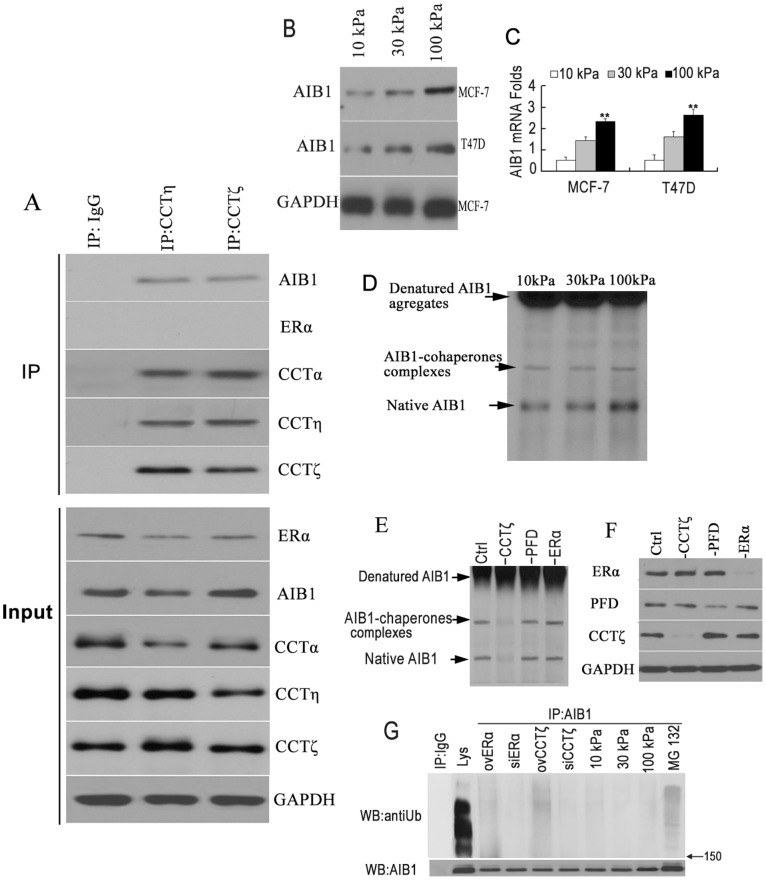
CCT6 (ζ) interacts with AIB1, and stimulates AIB1 refolding via a PFD-independent pathway.(A) MCF-7 cells were cultured on 100-kPa substrates, and then analyzed by co-immunoprecipitation (co-IP) assay followed by immunoblotting (IB) analysis after 72 h. (B) The expression of AIB1 was then assessed in two breast cancer cell lines (MCF-7 and T47D) grown on different rigidity substrates using Western Blotting. GAPDH was used as a control to confirm equal protein loading. Each lane was loaded with up to 30 µg of protein. (C) The mRNA expression of AIB1 in MCF-7 and T47D breast cancer cells grown on different rigidity substrates was assessed using real-time RT-PCR. **P<0.01 compared with 10 and 30 kPa substrates. (D) Altered CCTs folding activity on AIB1 changes in the MCF-7 cells grown on different rigidity substrates (10 kPa, 30 kPa, 100 kPa). (E) MCF-7 cell extracts were assayed before and after CCTζ, ERα, and PFD immunodepletion assayed using [35S]-labeled, and denatured AIB1 (500 ng per lane). The protein concentration of MCF-7 cells was 2.5 mg/mL. PFD immunodepletion did not affect AIB1 refolding. therefore, CCTs folded AIB1 in a PFD-independent pathway. (F) The levels of CCTζ, ERα, and PFD were measured in MCF-7 cell extracts after immunodepletion. (G) Ubiquitinated forms of AIB1 in cells grown on different rigidity substrates with ERα or CCTζ overexpression or knockdown were detected using co-immunoprecipitation (co-IP) with anti-AIB1 antibodies and Western blotting with anti-ubiquitin antibodies.